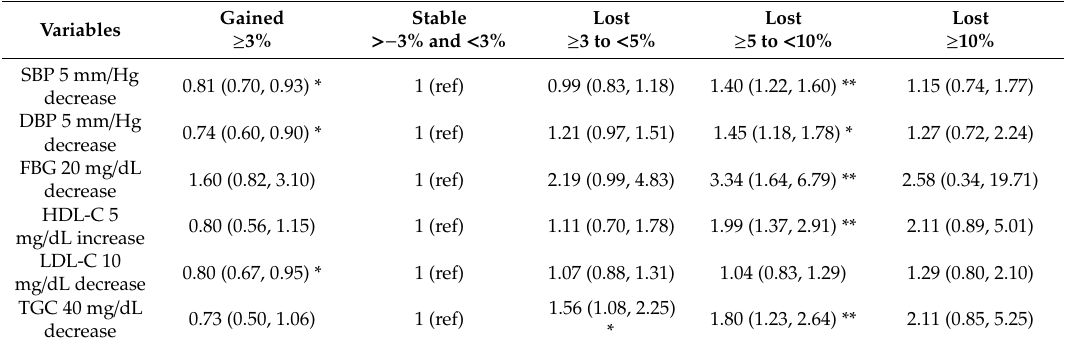
Table 3. Adjusted IRRs (95% CIs) of clinically significant changes in CVD risk factors associated with the weight change categories.